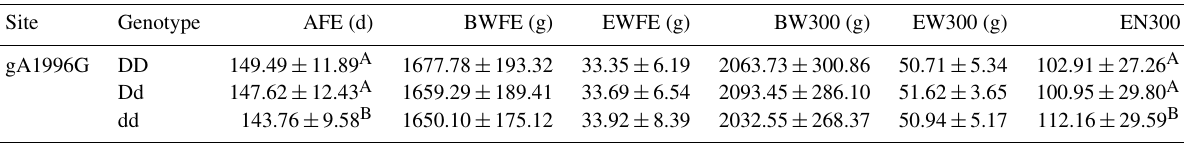
Table 3. Association analysis between different genotypes of the AMH exon 2 and reproductive traits in Jinghai Yellow chickens (mean ± SD).